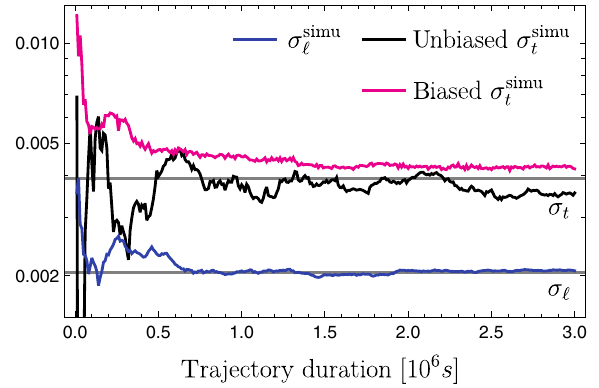
FIG. 17. Convergence analysis of the two contributions to the entropy production rate inferred from numerical simulations σ simu L for the model shown in Fig. 6 with bias parameter 8.6. The magenta line (top) is the intertransition times ’ Kullback-Leibler divergence σ simu t evaluated by the biased method from histogram counting. The black line (middle) is the intertransition times ’ Kullback-Leibler divergence σ simu t obtained using the unbiased method [70,71]. The blue line (bottom) is the estimate of the Kullback-Leibler divergence from the transitions ’ occurrence statistics from σ simu l . The analytical values of both σ t and σ l are shown by horizontal gray